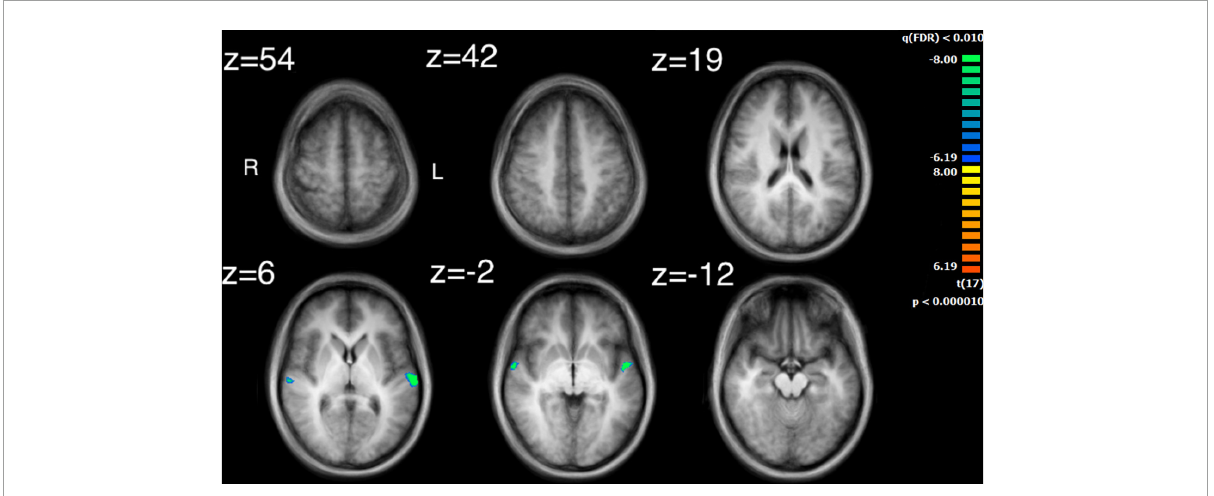
TABLE 5 Results of the visual feature analysis for the median values of movement similarity. Structure Hemisphere Talairach coordinate Number of voxels Peak statistic BA ( x , y , z ) Movement similarity Superior temporal gyrus Right (60, − 19, 4) 178 − 8.227 Superior temporal gyrus Right (57, − 4, 1) Superior temporal gyrus Left Superior temporal gyrus